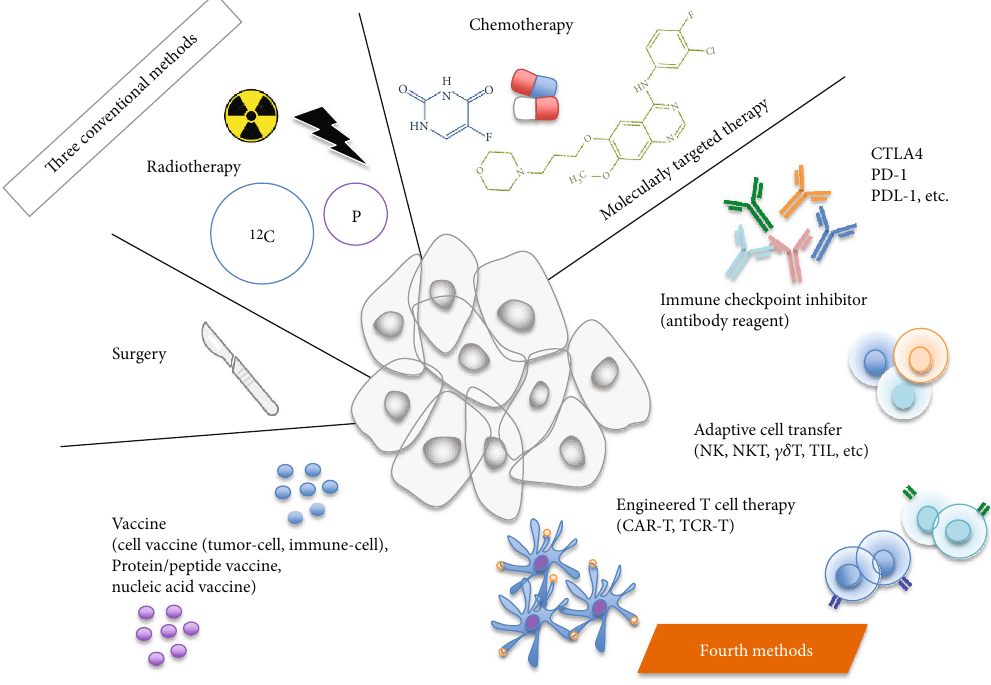
Figure 1: Cancer treatment methods. Conventional methods for cancer treatment include surgery, chemotherapy, and radiation therapy, which remove or directly attack the cancer cells. Recent advances in medical science have resulted in the addition of cancer immunotherapies as a fourth treatment method, which can indirectly attack cancers by regulating the patient ’ s